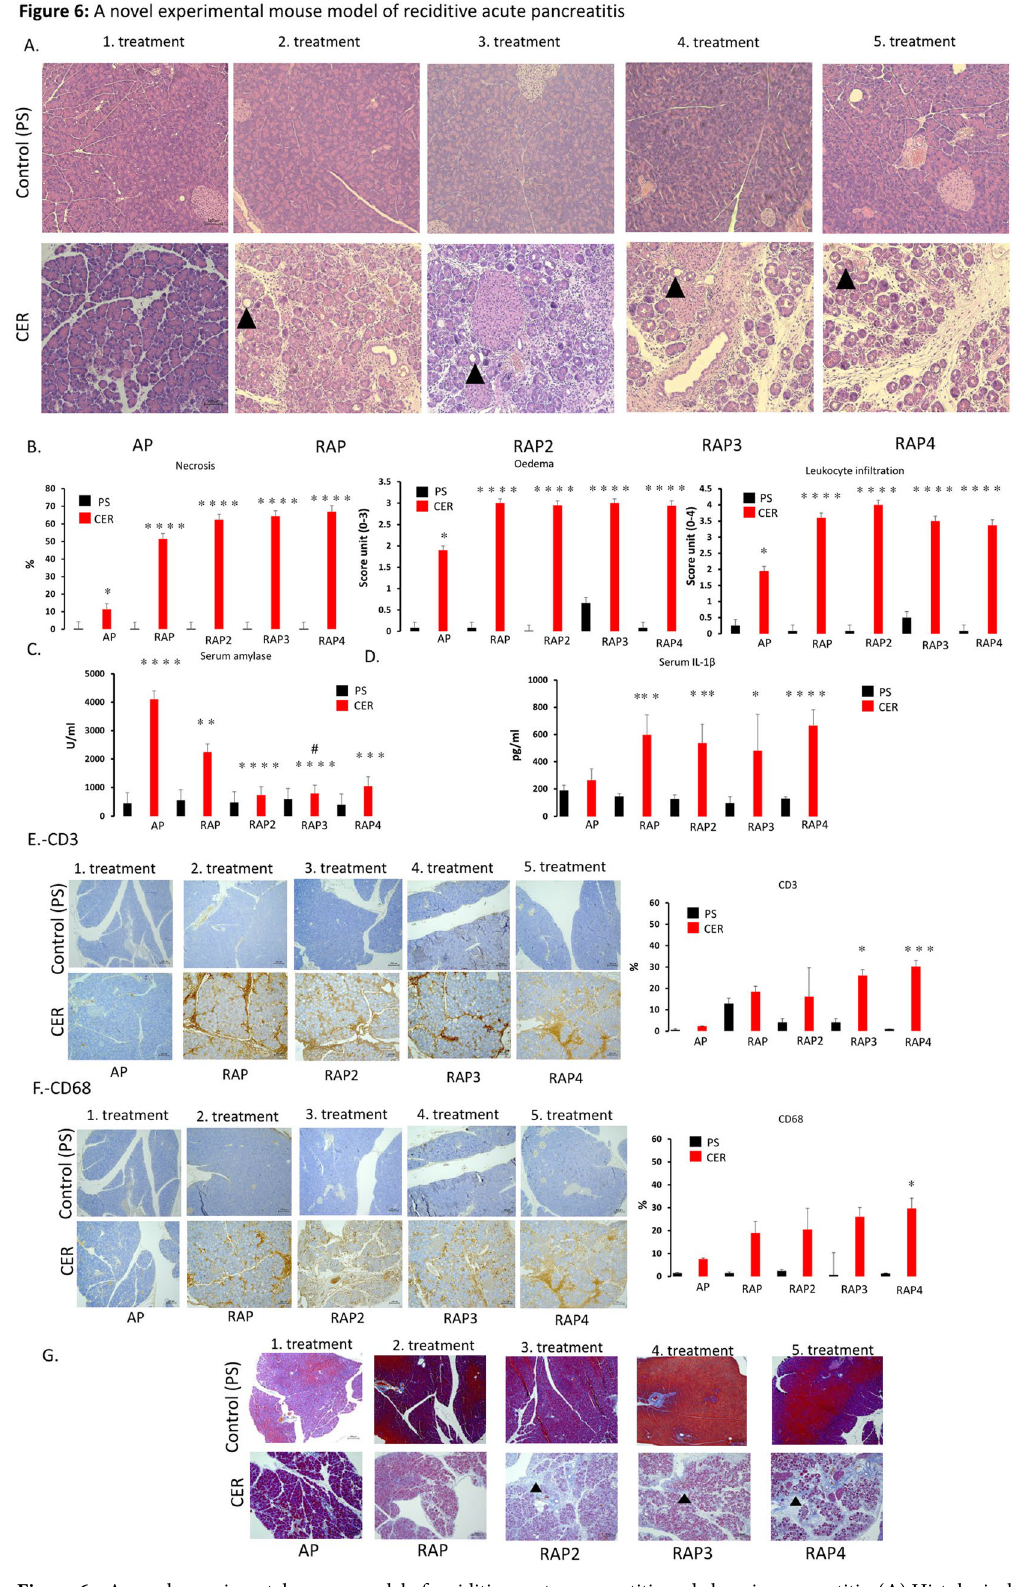
Figure 6. A novel experimental mouse model of reciditive acute pancreatitis and chronic pancreatitis. ( A ) Histological findings in an experimental mouse model of acute pancreatitis. ( B ) Necrosis, edema and leukocyte infiltration differences in pancreatitis stages in an experimental mouse model. ( C ) Serum amylase activity and ( D ) Serum IL-1β level differences in stages of pancreatitis in an experimental mouse model. ( E ) CD3 (T cell, brown colour) staining. ( F ) CD68 (macrophage, brown colour) staining. ( G ) Fibrosis (blue colour filled triangle), each scale bar represents 100 µm. * = p < 0.05. A detailed description can be found in Supplementary Document